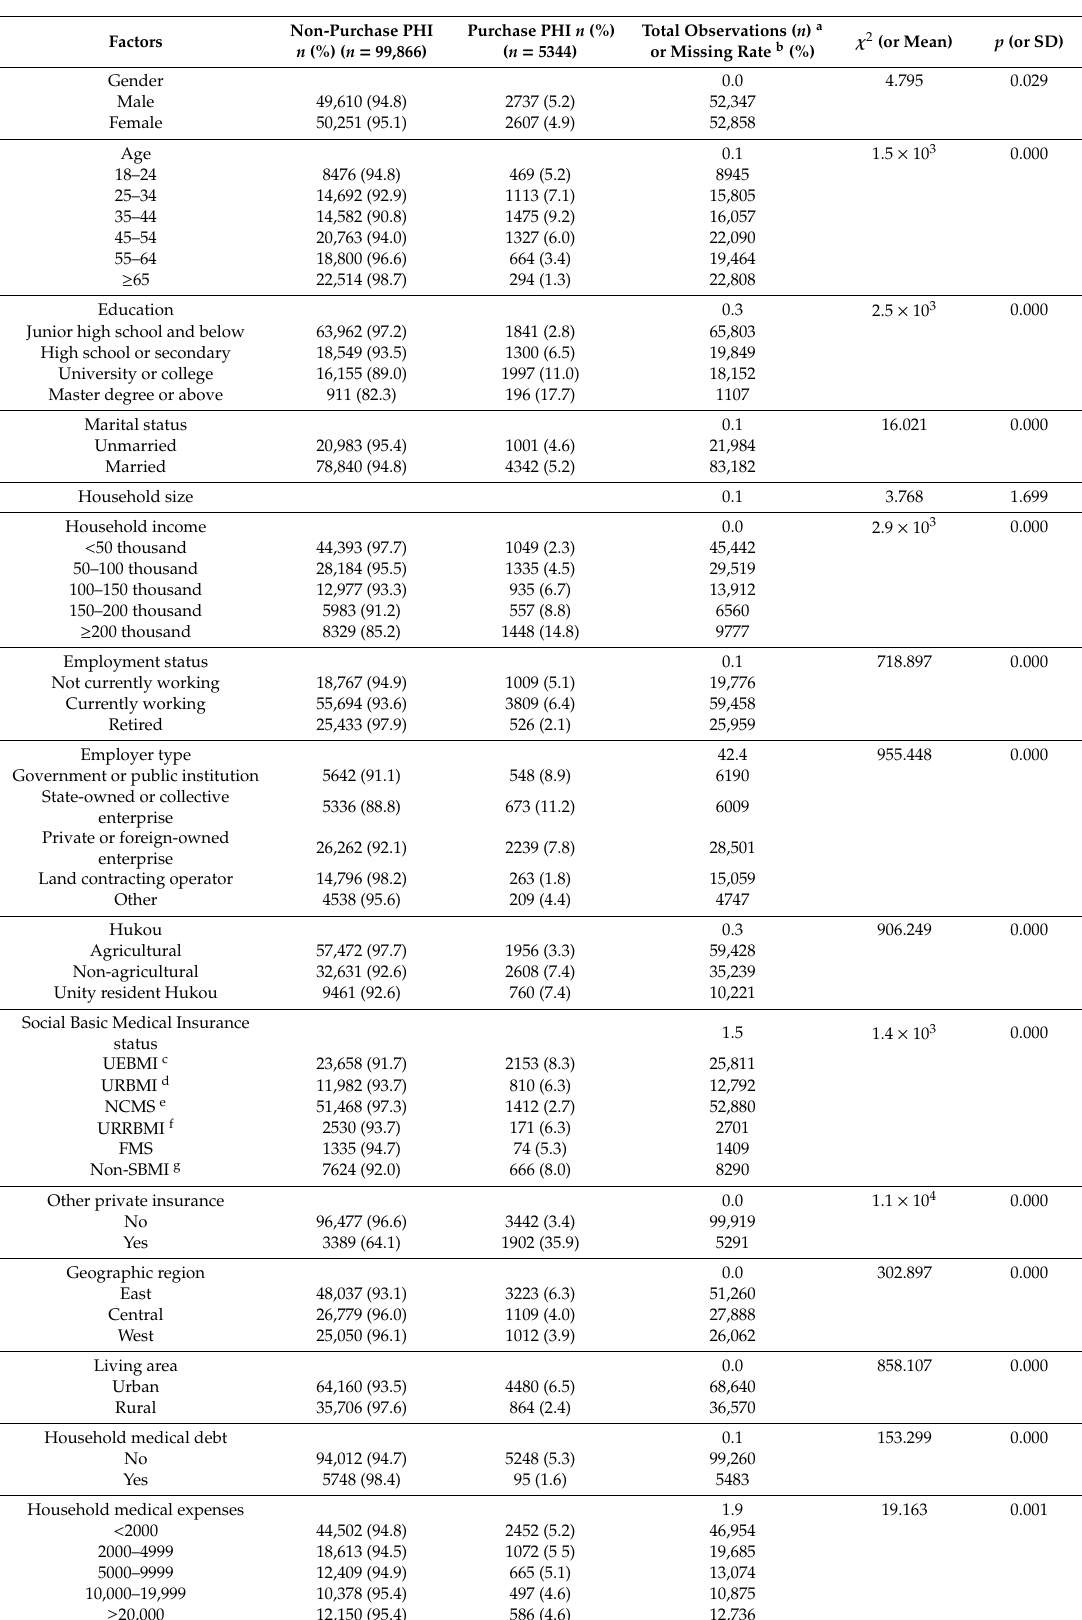
Table 2. Descriptive information on private health insurance (PHI) purchasing or non-purchasing under Andersen